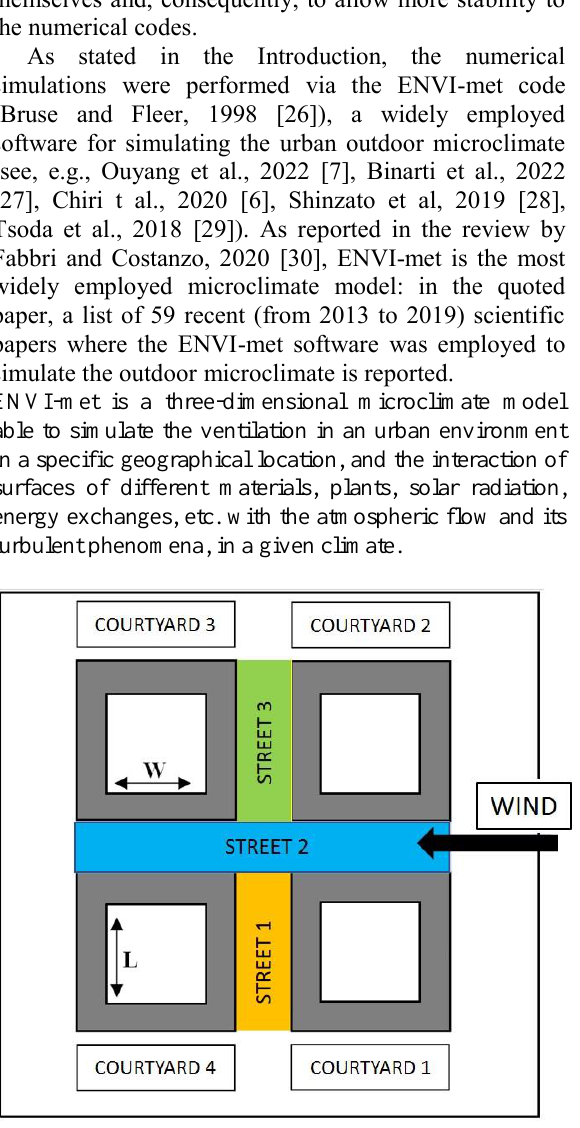
Fig. 1. Sketch of the group of courtyards, with the relevant dimensions, the wind direction, the names of the courtyards and the names of the